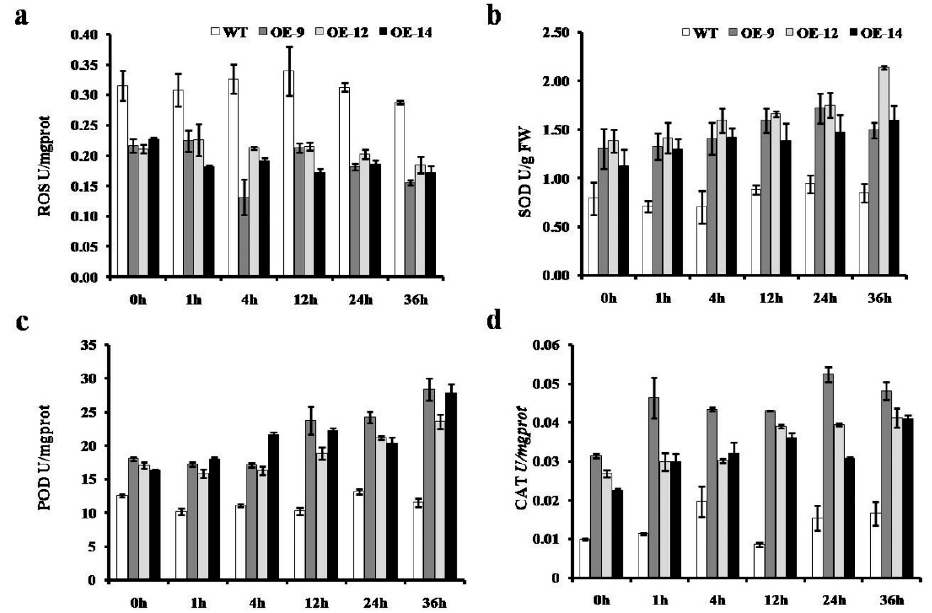
Figure 6. Activities of reactive oxygen species (ROS) ( a ), SOD ( b ), POD ( c ) and CAT ( d ) in the wild-type and overexpressed lines (OE-9, OE-12 and OE-14) under normal and drought conditions at various time points (0, 1, 4, 12, 24 and 36 h). Bars represent the standard deviation among three independent replicates.